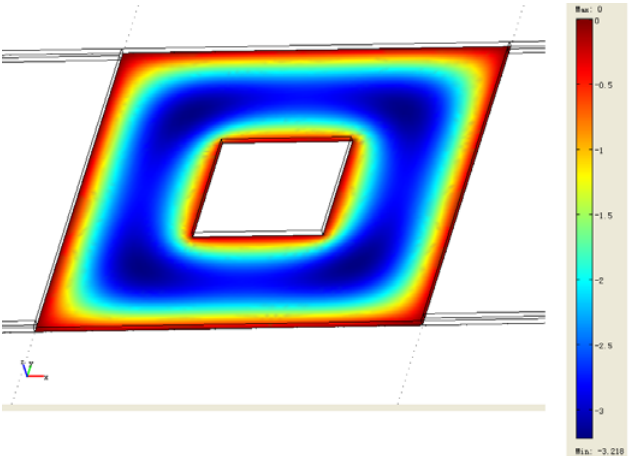
Figure 9. Distribution of pressure by damping.